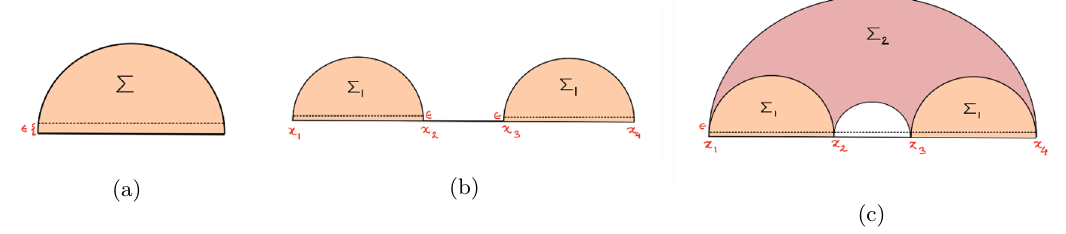
Figure 8. HRT surfaces and entanglement wedges in AdS 3 for one (a) and two intervals. The latter has two phases, (b) Phase I and (c) Phase